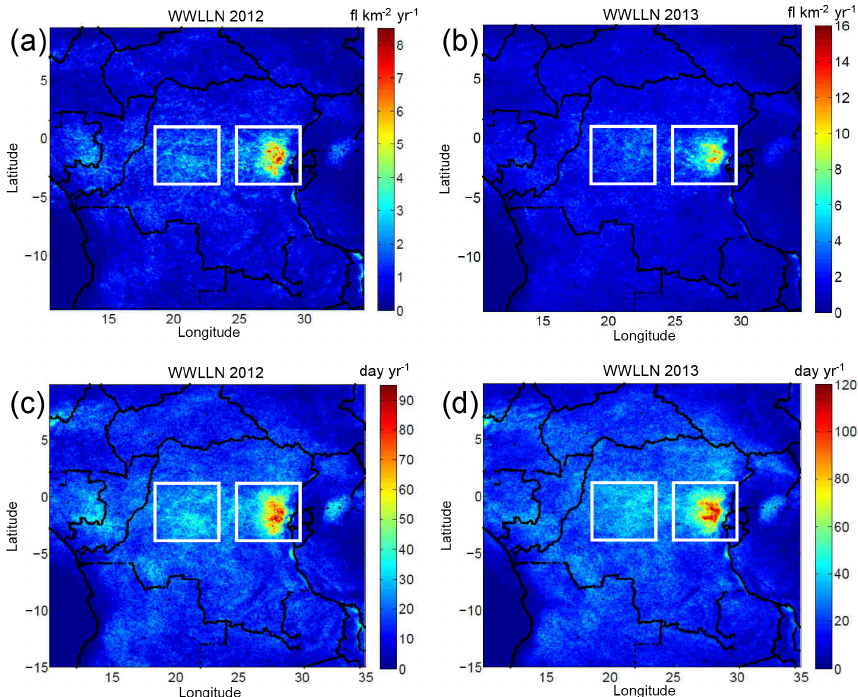
Figure 2. (a, b) Lightning FRD in flkm − 2 yr − 1 calculated at a resolution of 0.05 ◦ from WWLLN data in the area of Congo Basin for 2012 and 2013, respectively. (c, d) Number of days of the year with thunderstorm activity in the same area with a resolution of 0.05 ◦ for 2012 and 2013, respectively. The white frames indicate the two zones with strong activity (left, Area_sec; right,